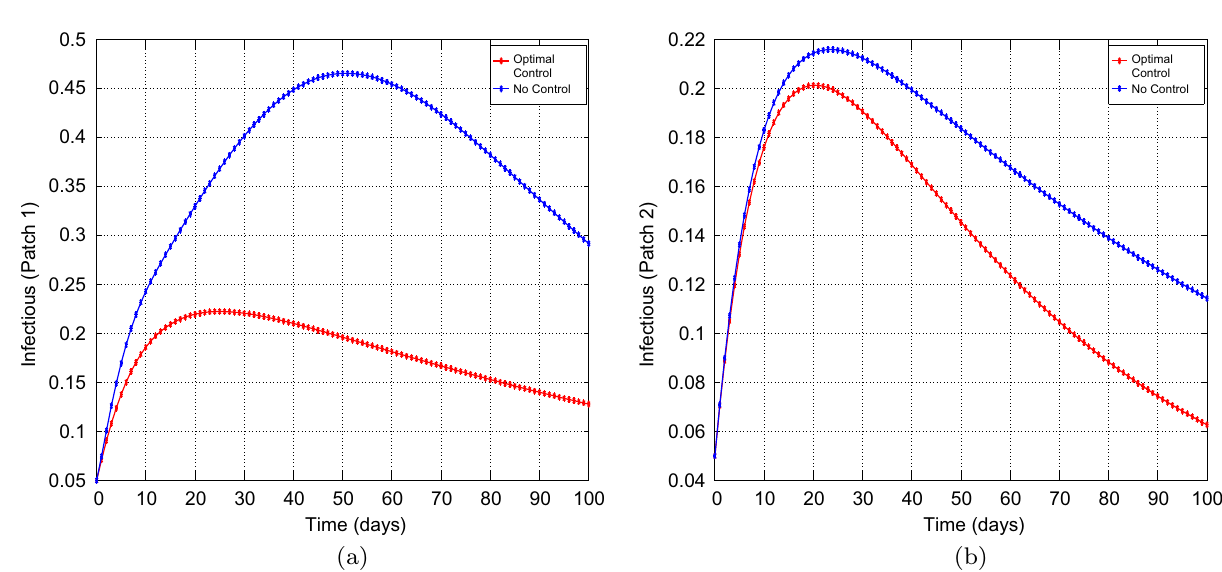
Figure 9. Simulation outcomes for the presented two patch COVID-19 mathematical model for case 2 under asymmetric weak coupling ( a ) the number of infected humans in patch 1 ( b ) the number of infected humans in patch 2. In both figures, the red curves and blue curves are for the infected population, with optimal control and no optimal control